Question: Looking at the figure, what chart type is it?
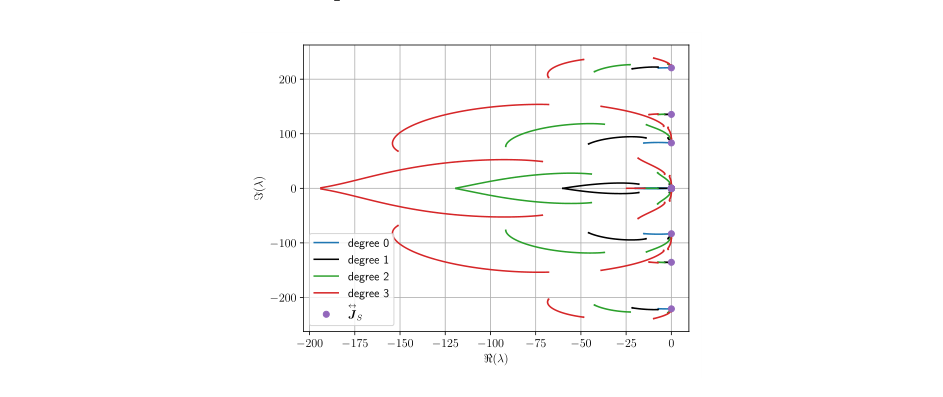
Answer: line